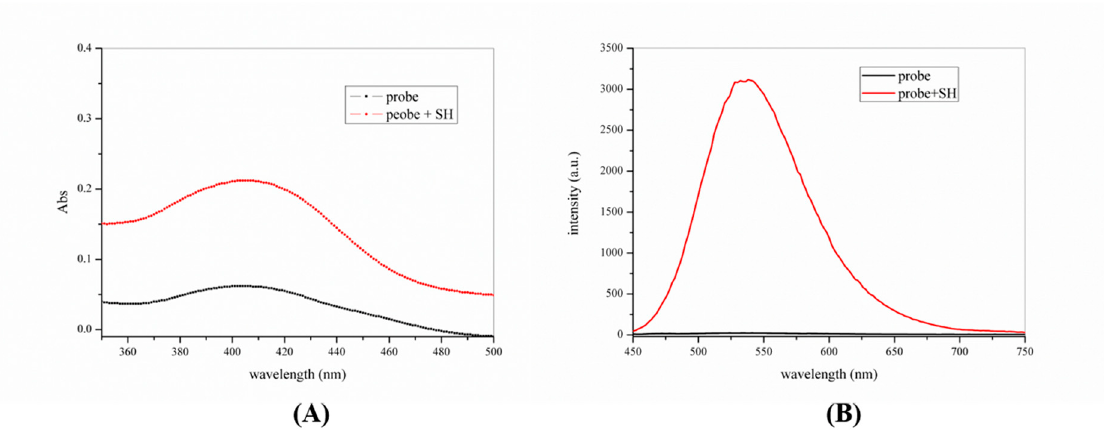
Figure 1. ( A ) Absorption spectra and ( B ) fluorescence spectra of probe-KCP (10 µ M) in the presence of 100 µ M 4-methoxythiophenol (red) in DMSO/PBS (1:1, v / v , 20 mM, pH = 7.4). λ ex = 410 nm and λ em = 540 nm.